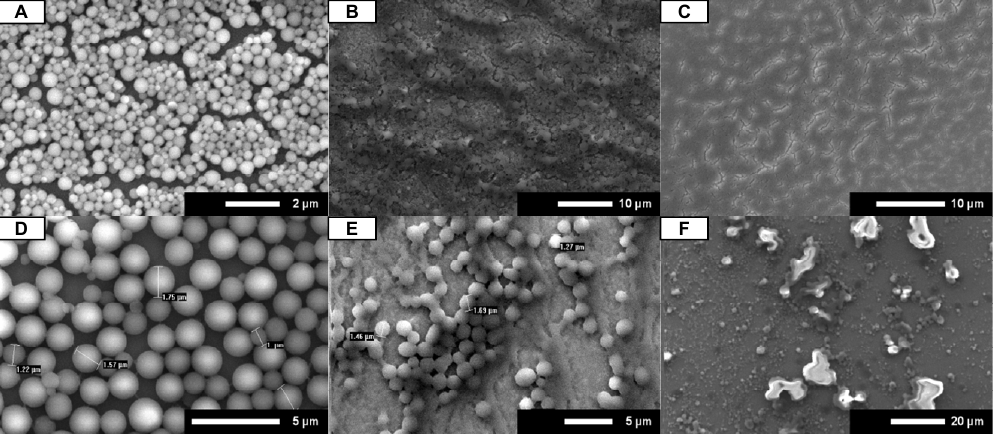
Figure 4. SEM images for A (A–C) and B (D–F). Peptoids were dissolved in 4:1 isopropanol:water and administered by full coverage. Peptoids were dried in open air (A and D), humidity chamber (B and E), and vacuum chamber (C and F). Scale bars are as